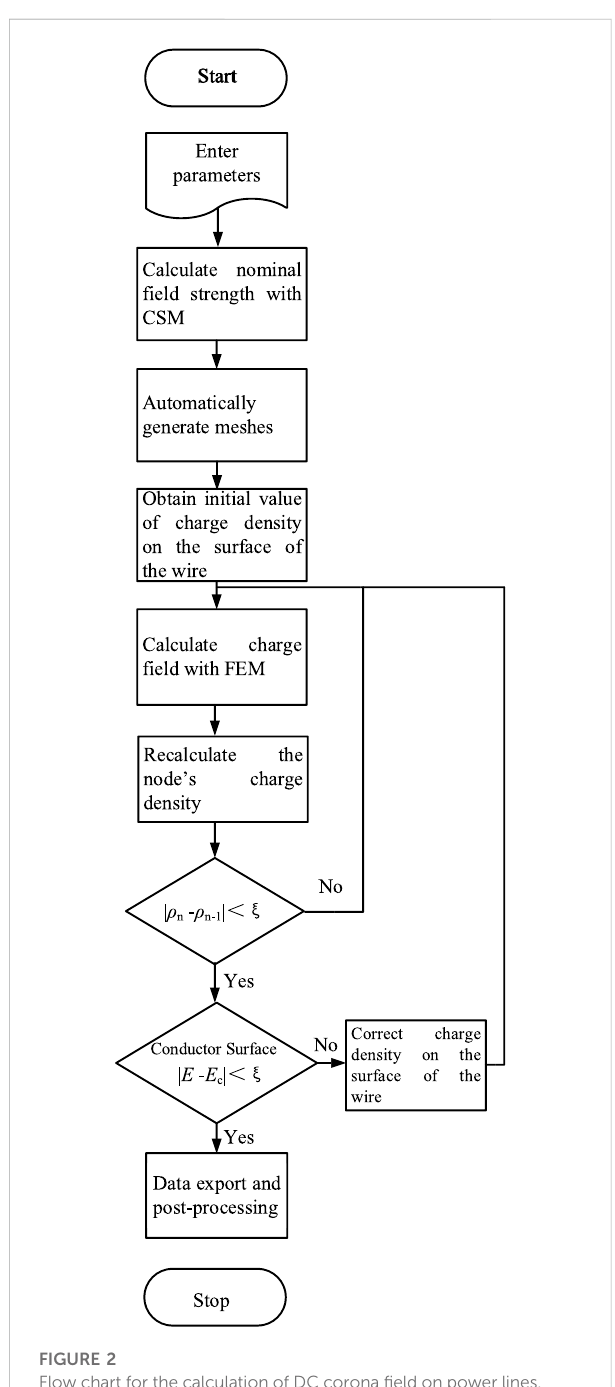
FIGURE 2 Flow chart for the calculation of DC corona fi eld on power